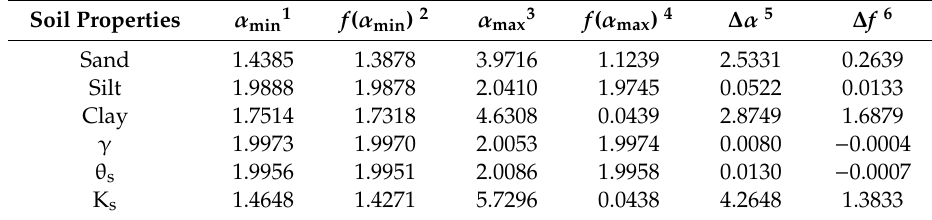
Table 5. Multifractal spectral parameters of soil properties in the study